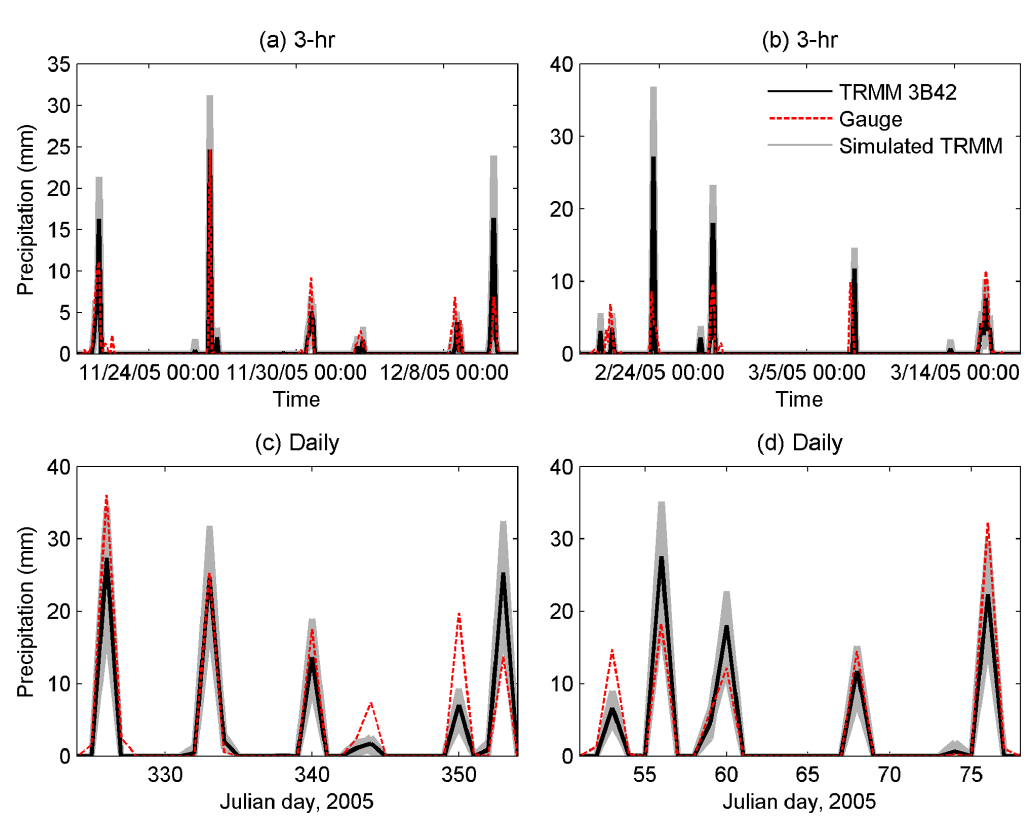
Figure 3. Ensembles of simulated satellite precipitation data over the A-marked [(a) and (c)] and B-marked [(b) and (d)] pixels.